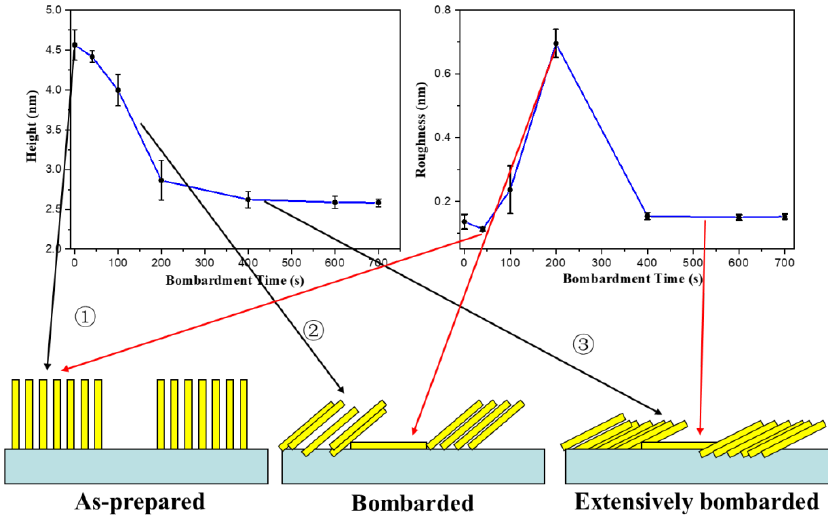
Figure 10. Proposed cross-linking processes of the film during HHIC, as confirmed by AFM images of measured height and roughness change for different process of the cross-linking.